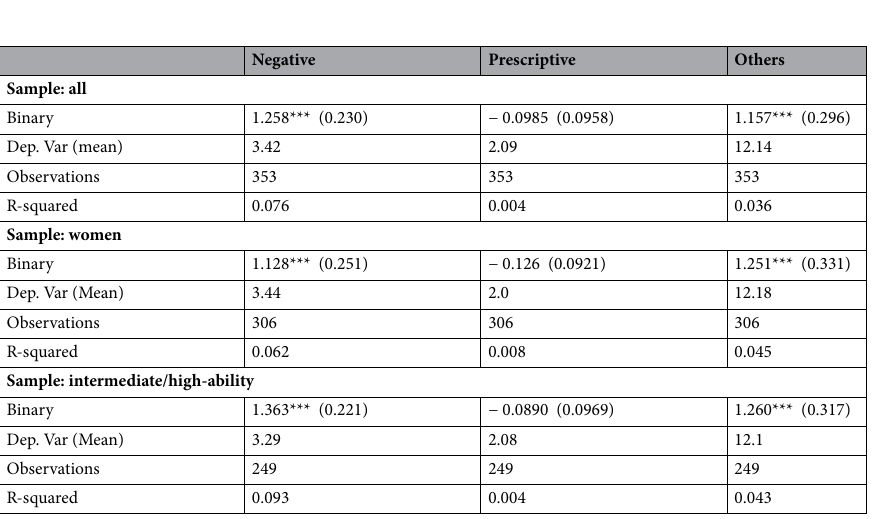
Table 2. The role of question-wording. The dependent variable is the number of “Yes” responses by subjects in the questionnaire. The “Negative” column refers to the negative questions, the “Prescriptive” column refers to the prescriptive questions, and the “Others” column refers to questions that cannot be classified as either negative or prescriptive. Robust standard error in parentheses. Standard errors clustered at the school level. ***p < 0.01, **p < 0.05, *p <